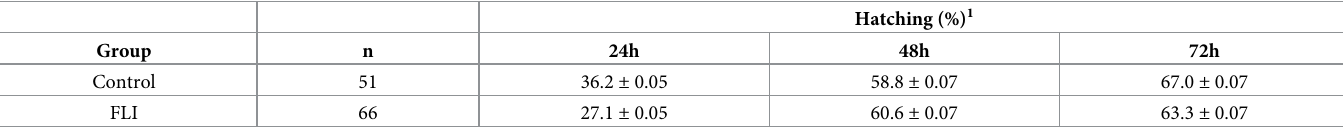
Table 2. Hatching rates post-thaw of bovine embryos supplemented with and without FLI during maturation following cryopreservation by